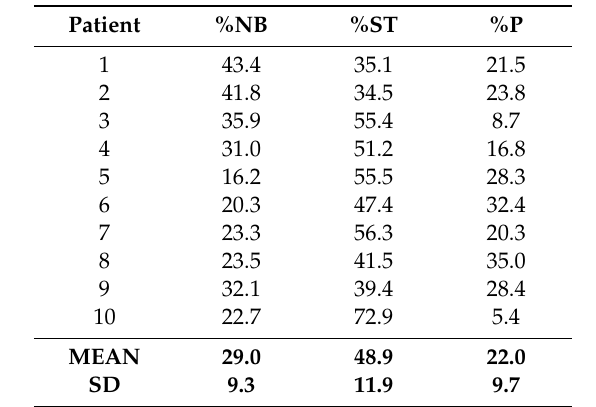
Table 2. Histomorphometric outcomes: percentages of newly formed bone (NB), percentages of soft tissue (ST), percentages of biomaterial graft particles (P). Mean value (Mean) and standard deviation (SD) at six-month follow-up were reported.